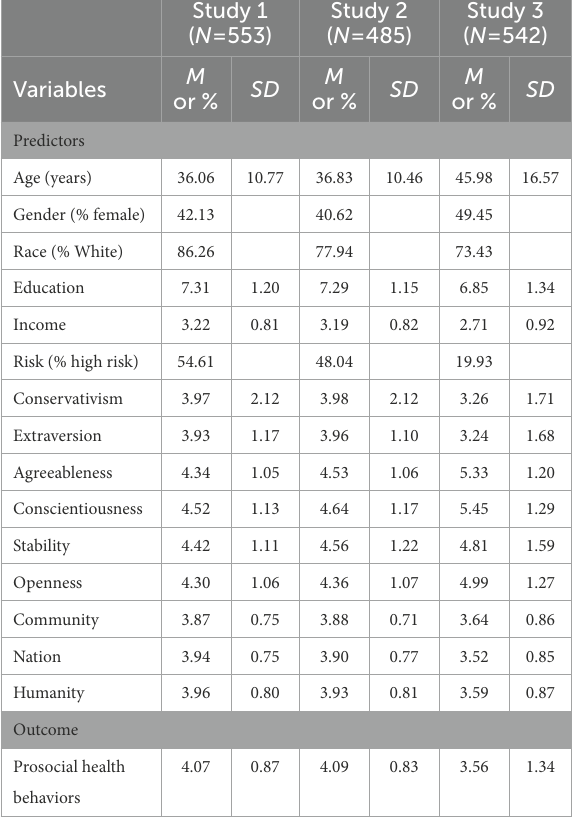
TABLE 1 Descriptive statistics for predictor and outcome variables in Study 1, 2, and